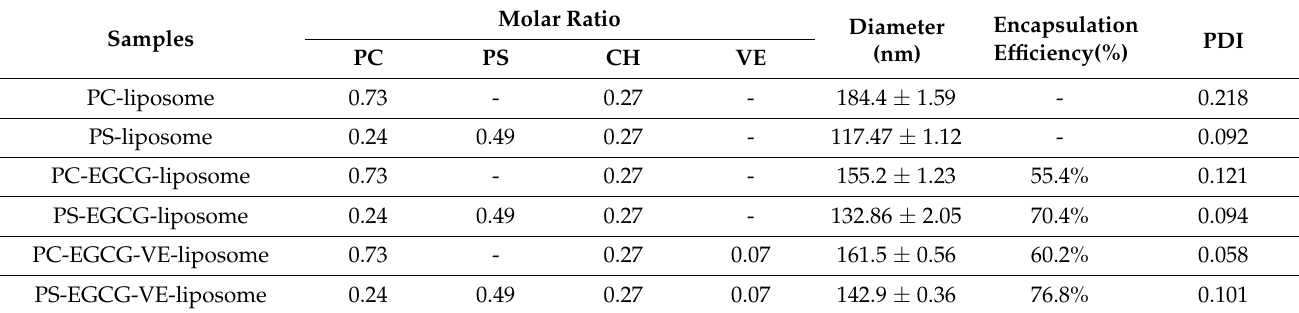
Table 1. Characteristics of the formulation of EGCG-loaded